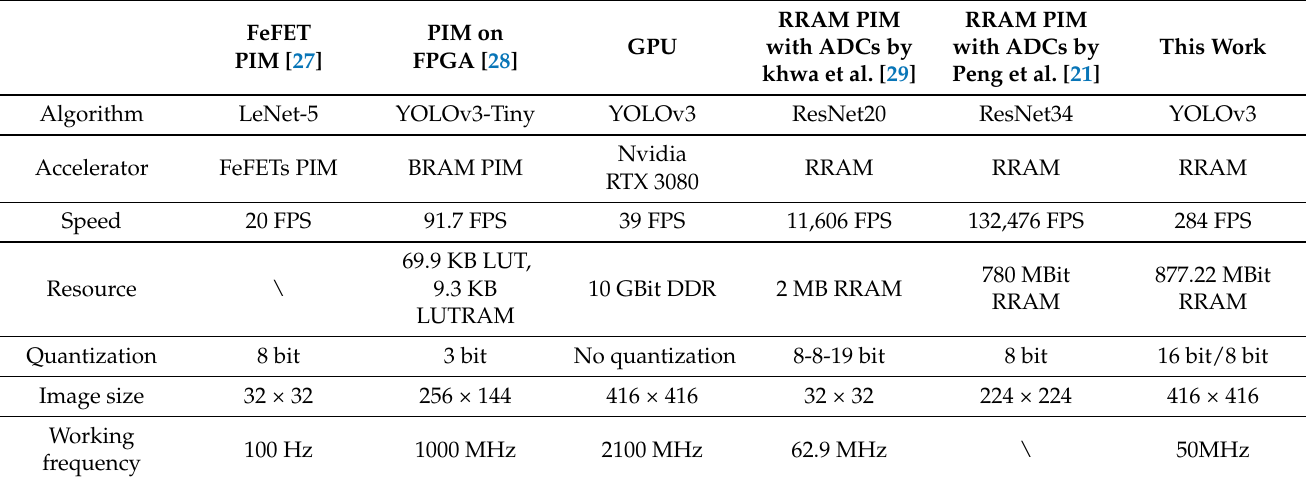
Table 3. Comparison of operation and memory resource among different